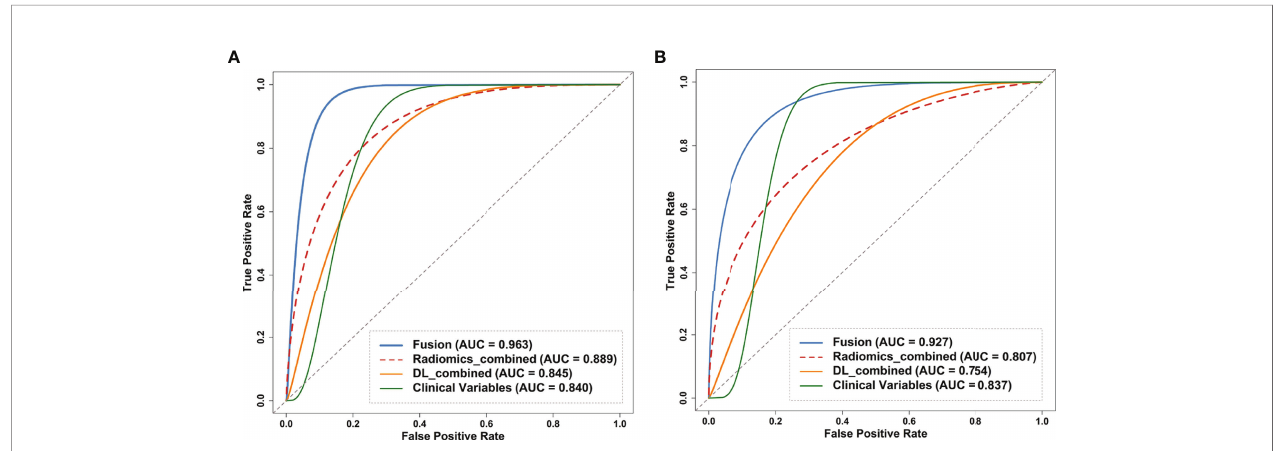
FIGURE 5 | Receiver operating curves (ROC) of the clinical model, DL_combined model, radiomics_model and fusion model on the (A) internal and (B) external test dataset. Fusion model was developed by combing clinical variables, DL_combined features and radiomics_combined features. ROC, receiver operating characteristic curve; DL, deep learning.